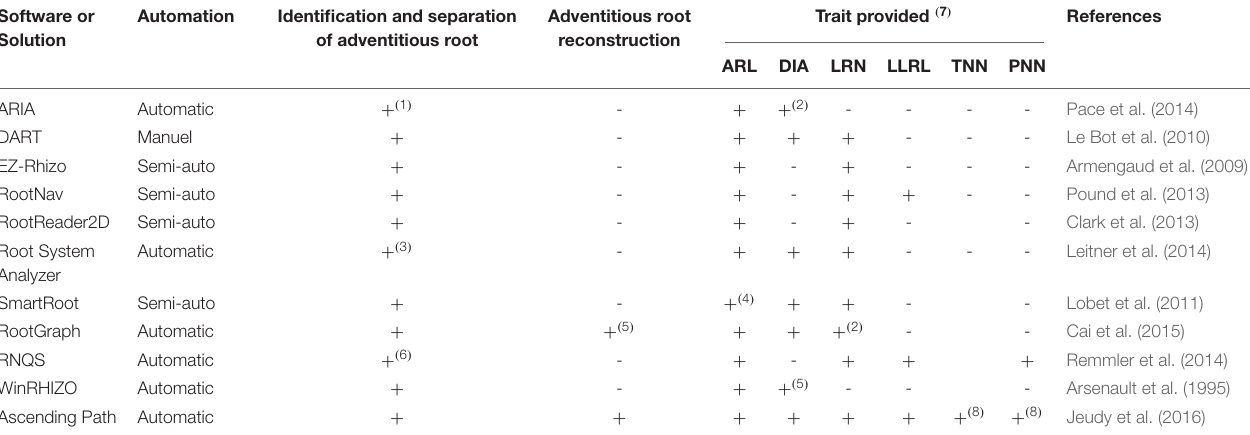
TABLE 1 | Summary of currently available tools and the proposed method, for analysis of root images and the respective traits provided. Software or